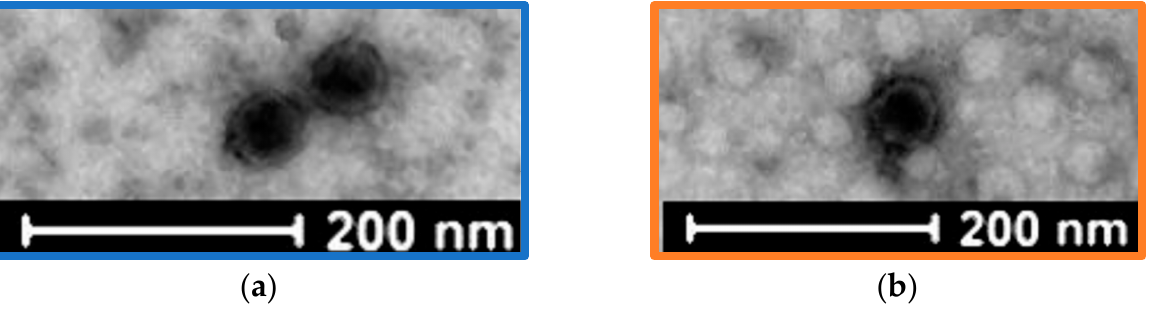
Figure 1. Negative staining transmission electron microscopic images: ( a ) vB_KpnP_K3-ULINTkp1 and ( b ) vB_KpnP_K3-ULINTkp2.